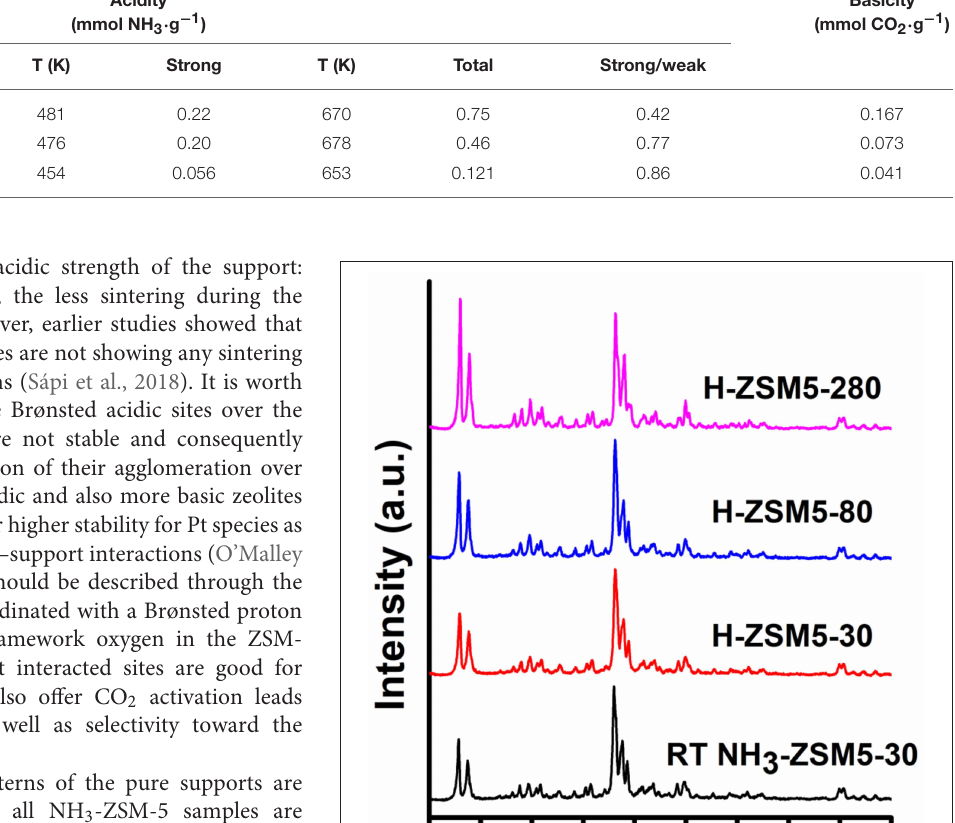
TABLE 2 | Acidity and basicity of NH 3 -ZSM-5 catalysts. Catalyst